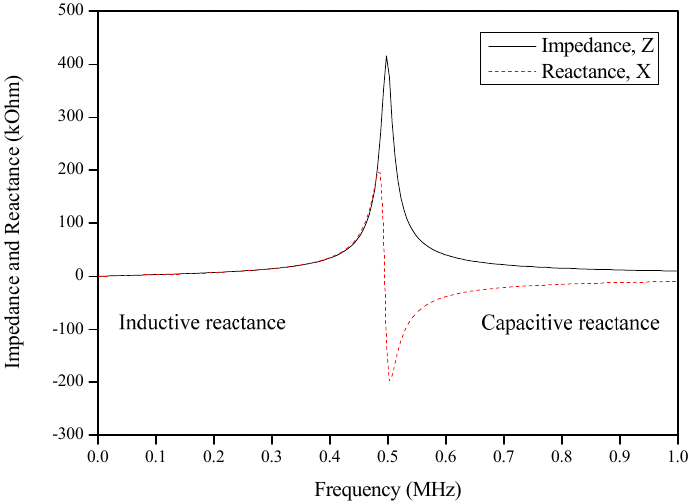
Figure 2. Example of the air core inductor impedance and reactance.